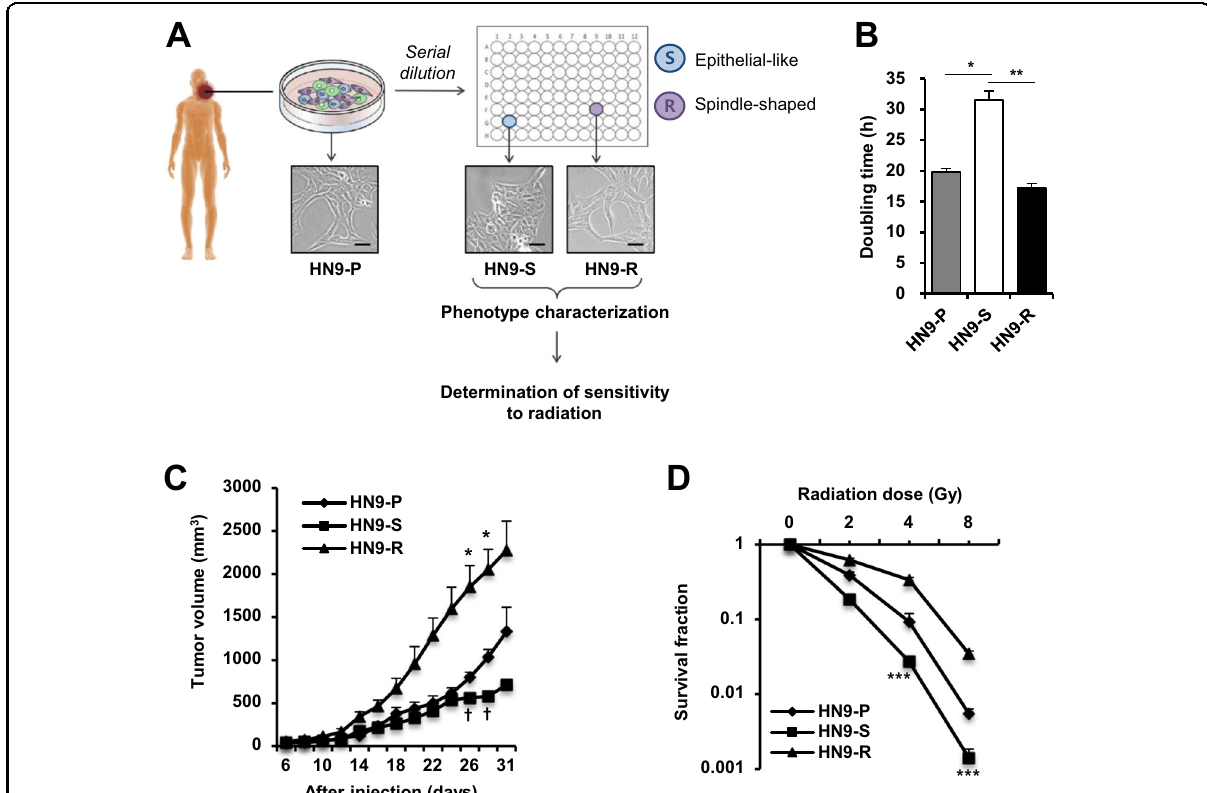
Fig. 1 Two subclones derived from a primary head and neck tumor display a distinct growth rate and sensitivity to irradiation. A Schematic diagram of isolation and functional characteristic analysis of two subclones (HN9-S and HN9-R) from HN9 parental cancer cells (HN9-P). Scale bars, 20 μ m. B – D The cells were measured on in vitro cell proliferation by doubling time ( B ), growth rate of xenograft tumors ( C ), and clonogenic survival after irradiation ( D ). In Fig. 1C, * and † indicate HN9-R vs. HN9-P and HN9-S vs HN9-P with p < 0.05,